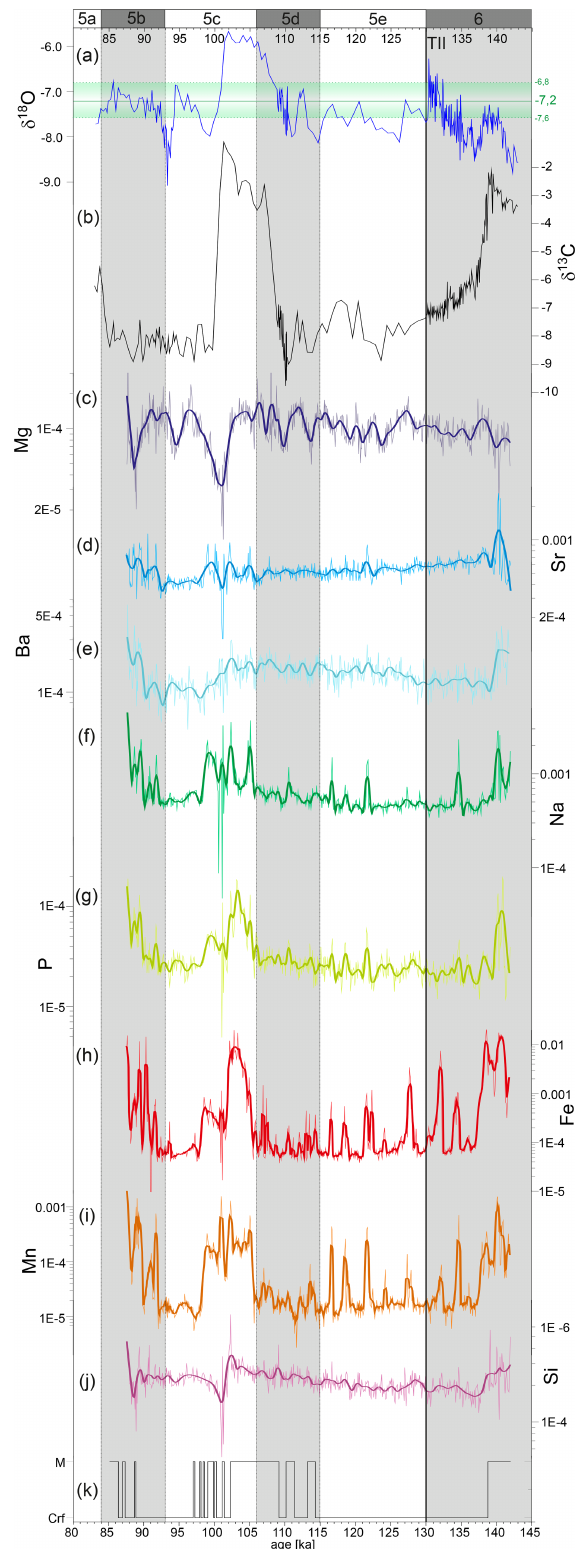
Figure 4. Results of multiproxy analyses of the JS9 stalagmite: (a) δ 18 O composition with the mean value for the Holocene from DCS shown as a green line, (b) δ 13 C composition, (c) Mg content, (d) Sr content, (e) Ba content, (f) Na content, (g) P content, (h) Fe content, (i) Mn content, (j) Si content and (k) the microfabrics log. The data are available at https://doi.org/10.6084/m9.figshare.13116506.v1. Clim. Past, 17, 1051–1064,